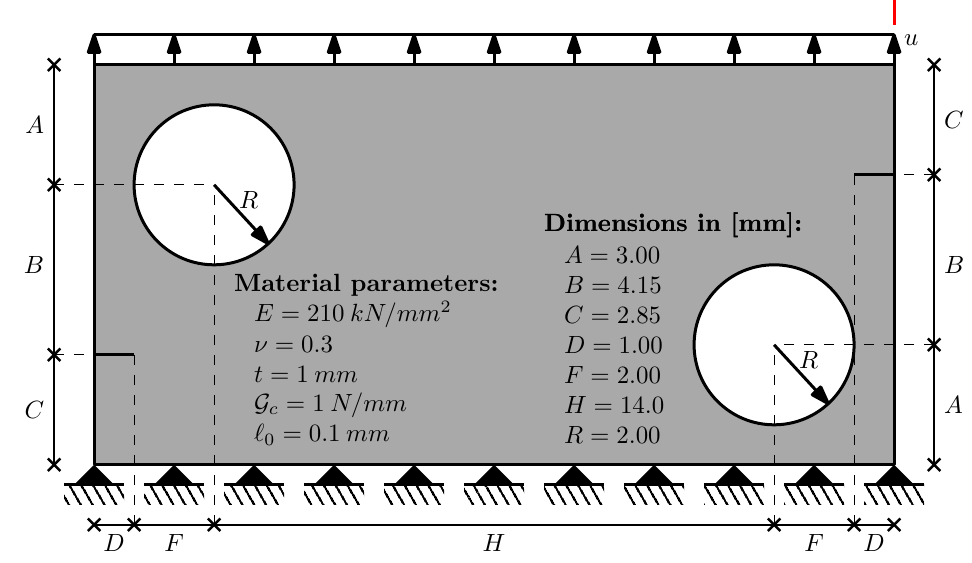
Figure 37. PwHC geometry, material parameters, loading and boundary